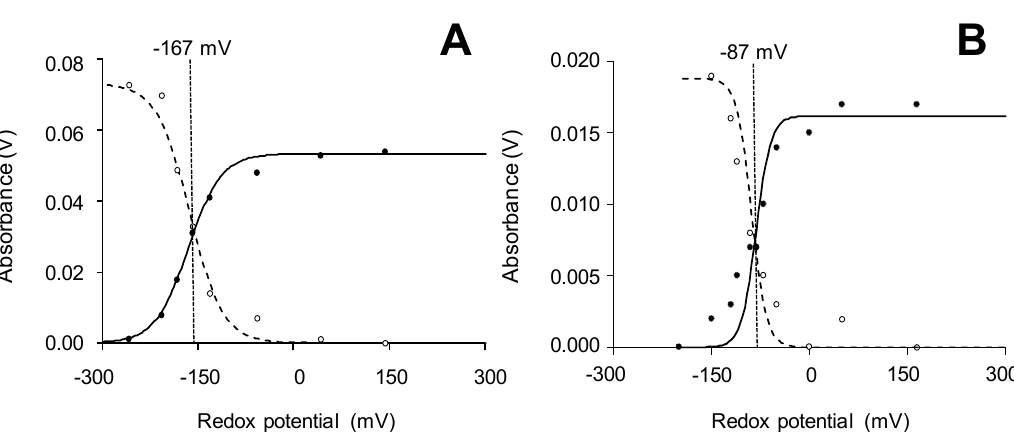
Figure 3. Two examples of spectro-electrochemical titration of Fe 3+ (continuous line, A 410 ) reduction to Fe 2+ (dashed line, A 438 ) in Aau DyP ( A ) and Per VPL ( B ). The potentials are referred to the standard hydrogen electrode. Data were fitted to the Nernst equation for a reversible one electron transition.